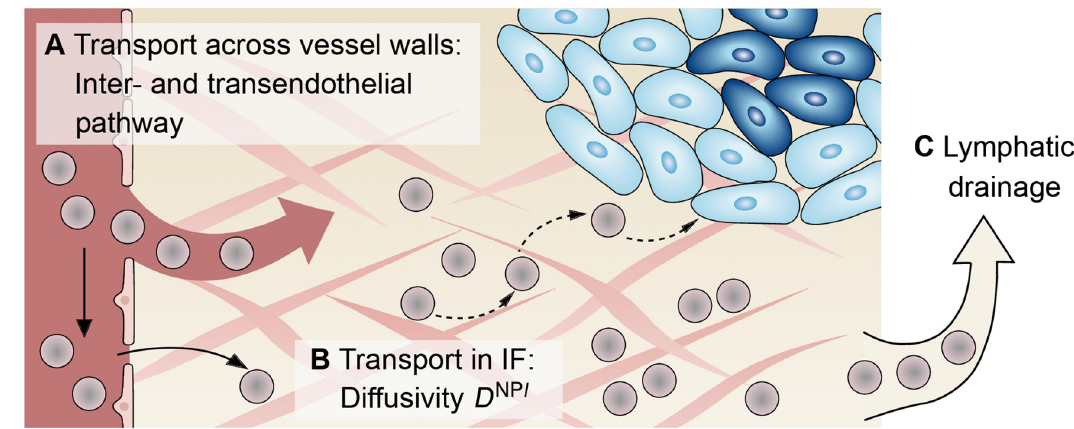
Fig 5. Transport barriers to nanoparticle transport. (A) Transport across the vessel wall via the interendothelial and/or the transendothelial pathway. (B) Transport in the IF characterised by the diffusivity D NP l . (C) Removal by the lymph system via lymphatic